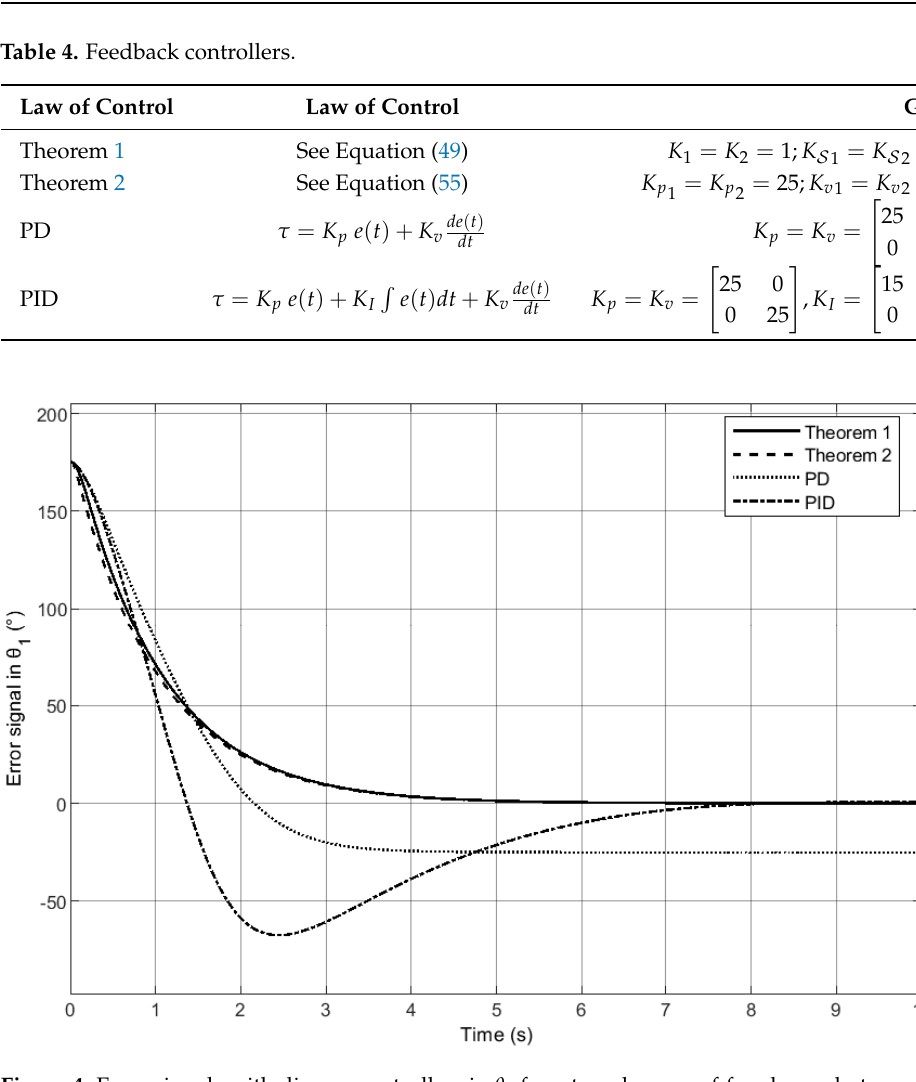
Figure 4. Error signals with diverse controllers in θ 1 for a two degrees-of-freedom